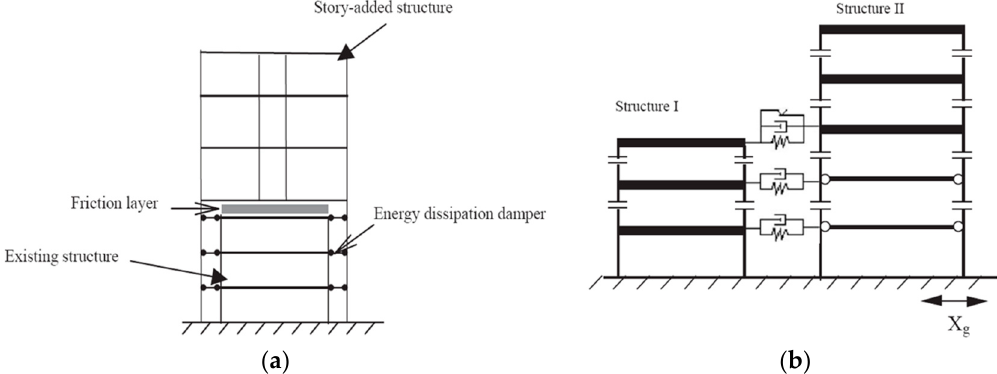
Figure 2. Story-increased buildings with friction layer and energy-dissipating devices. ( a ) Structural system model; ( b ) Simplified computational model for structural system.